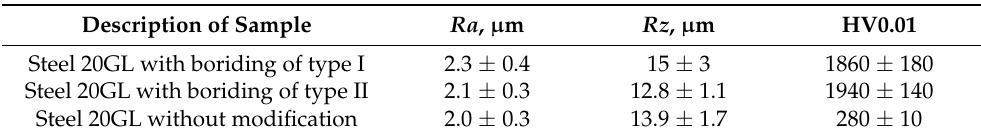
Table 2. Results of microhardness and surface roughness measurements of top and surface damage of samples with different types of surface modification in 600 min of testing.